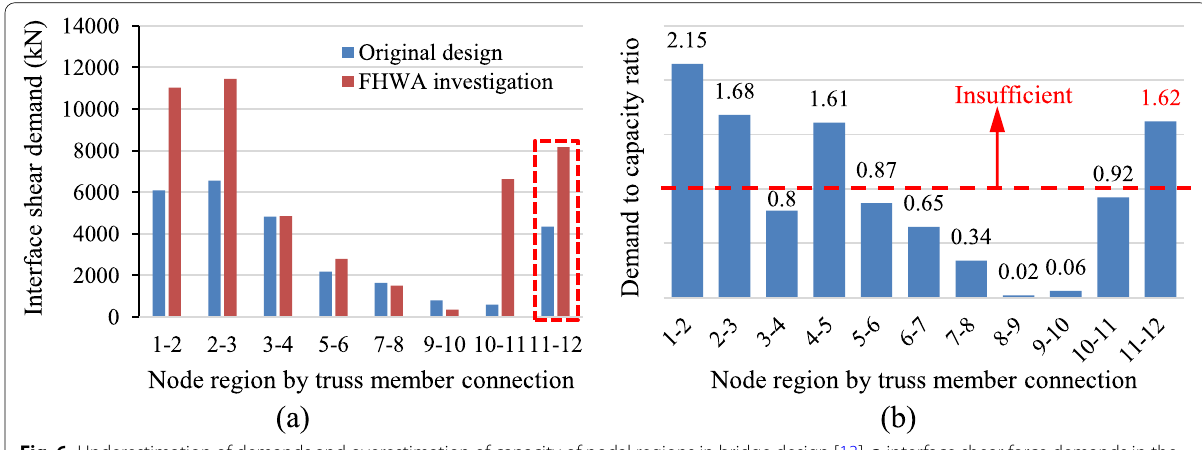
Fig. 6 Underestimation of demands and overestimation of capacity of nodal regions in bridge design [13]: a interface shear force demands in the original design and FHWA investigation; and b demand to capacity ratios for nodal regions